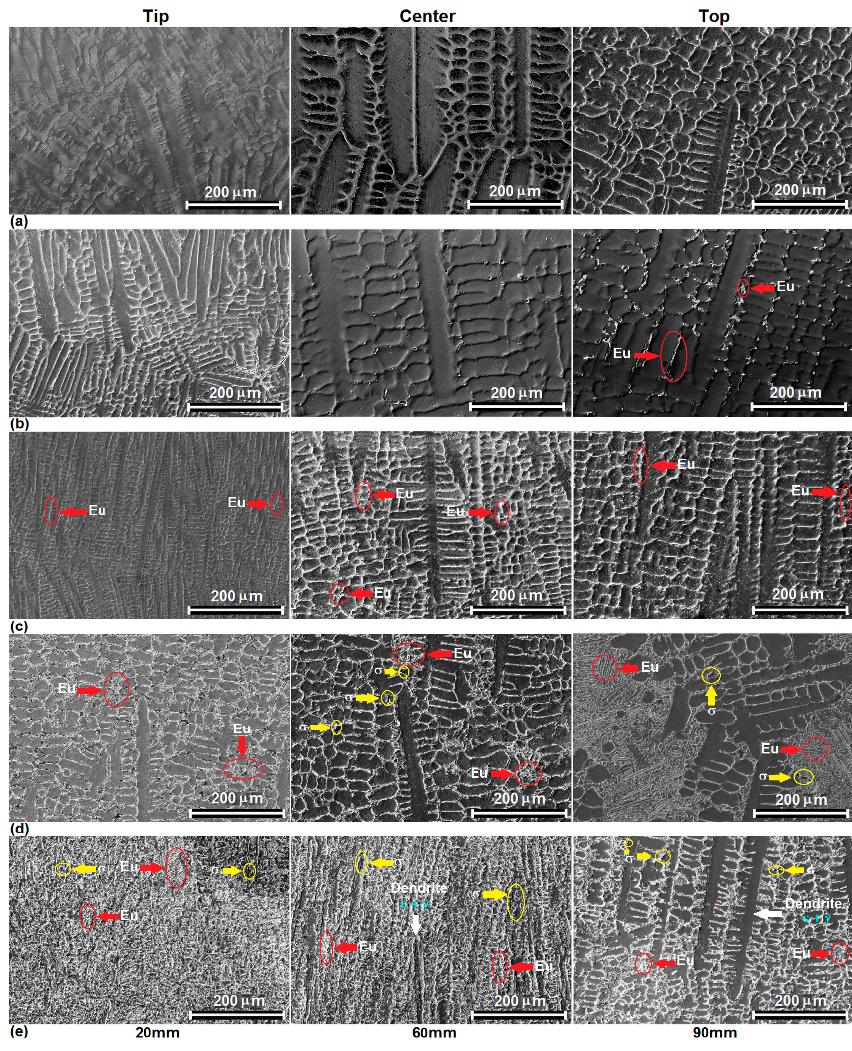
Figure 3. Microstructures found in wedge shaped Co–Cr alloy ingots. ( a ) Co ‐ 20 wt. % Cr, ( b ) Co ‐ 30 wt. % Cr, ( c ) Co ‐ 35 wt. % Cr, ( d ) Co ‐ 40 wt. % Cr, and ( e ) Co ‐ 44 wt. % Cr. It is important to note that